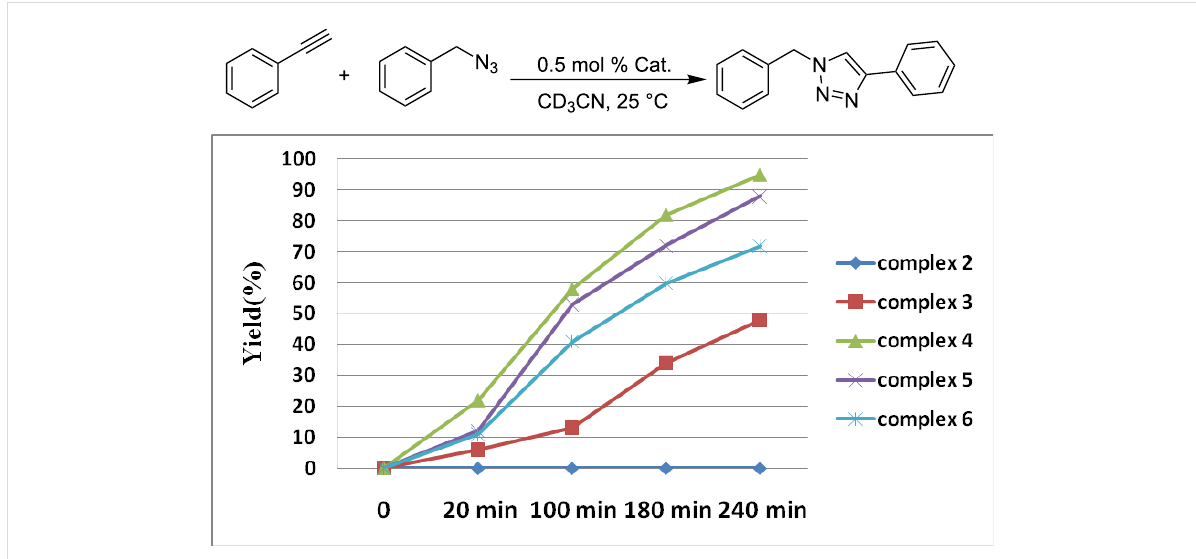
Figure 6: Yield vs reaction time of different copper complex. The reaction was carried out in acetonitrile- d 3 at 25 °C using 0.5 mol % copper complex, yields were determined by 1 H NMR spectra, hexamethylbenzene was used as internal standard.